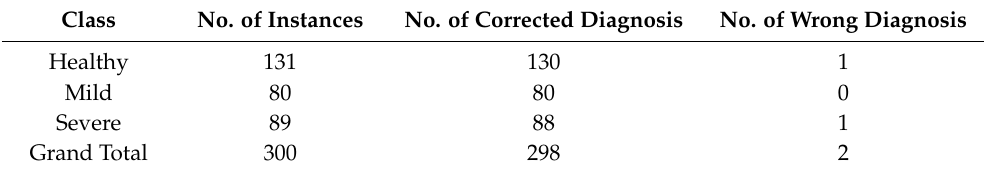
Table 6. Results of system for diagnosis of breast cancer